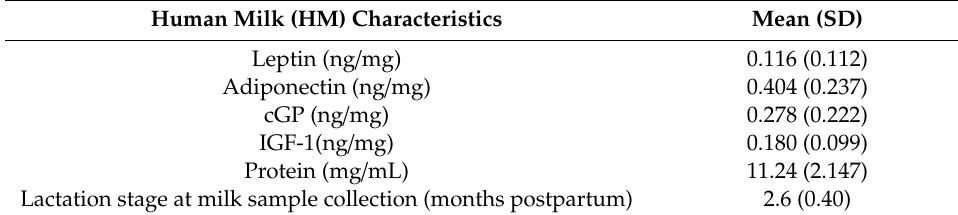
Table 2. Characteristics of milk samples for n = 501 mothers and n = 507 infants taking part in the Finnish STEPS